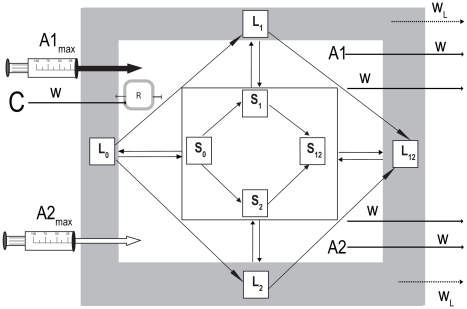
Two-compartment population and evolutionary dynamic model of two-drug antibiotic therapy.Main (active) compartment: S0, bacteria susceptible to both antibiotics; S1, bacteria resistant to antibiotic 1; S2, bacteria resistant to antibiotic 2, S12, bacteria resistant to both antibiotics. Latent (refractory) compartment: L0, bacteria susceptible to both antibiotics; L1, bacteria resistant to antibiotic 1; L2, bacteria resistant to antibiotic 2, L12, bacteria resistant to both antibiotics. C, reservoir resource concentration; R, internal concentration of the limiting resource; A1 and A2, internal concentrations of the antibiotics; A1max and A2max, concentration of antibiotics added periodically; w, flow rate of resources into and out of the compartments; wL, flow rate of latent population from the latent compartment.